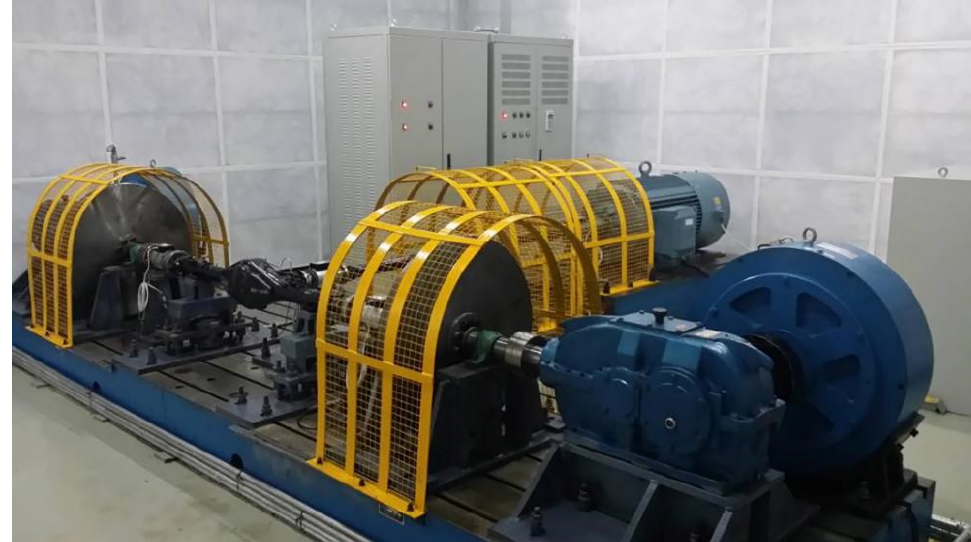
Figure 6. Assembled test rig in a semi-anechoic chamber.